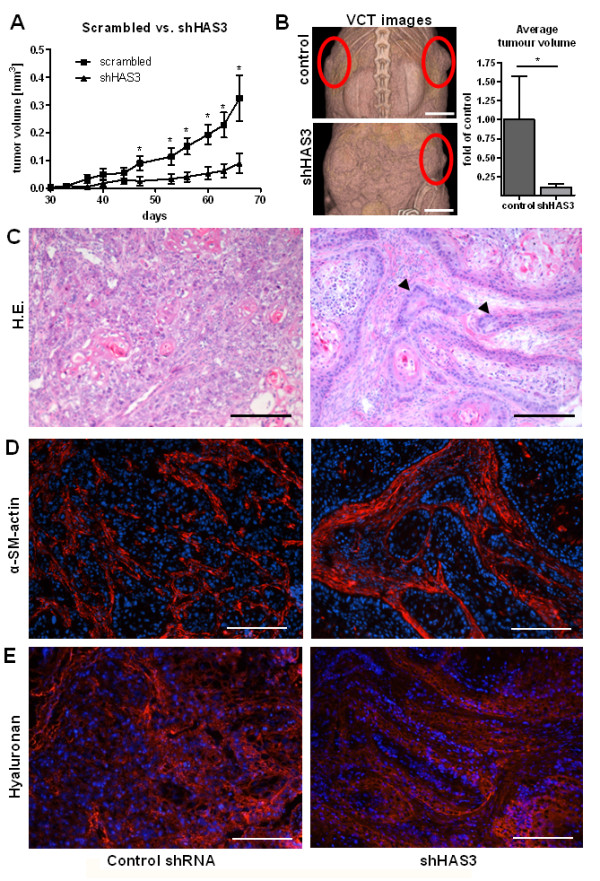
Lentiviral knockdown of HAS3 in OSC1 cells inhibited tumour growth after xenografting of transduced cells into nude mice. (A) Nude mice received subcutaneous injections of 106 OSC1 cells that had been transduced in vitro with a lentivirus containing either scrambled shRNA (control) or shHAS3. Tumour growth as assessed by calliper measurements; mean ± SEM, n = 6 (control), 7 (shHAS3); *, p < 0.05. (B) Representative fpVCT images of mice after 65 days. Average tumour volumes after sacrification of mice at the end of the experiment as measured by fpVCT showed also a significant reduction in tumour volume in the shHAS3 group. (C) H&E revealed changes in tumour morphology strikingly similar to those after 4-MU (compare Figure 2). (D) Tumour stroma was visualised by alpha-smooth muscle actin staining (red). (E) Xenografting shHAS3 tumour cells caused redistributed hyaluronan staining specifically localised to the outer layer of tumour cell clusters. Scale bars, 200 μm. Shown are representative images of n = 6 (control) and n = 7 (shHAS3) experiments.